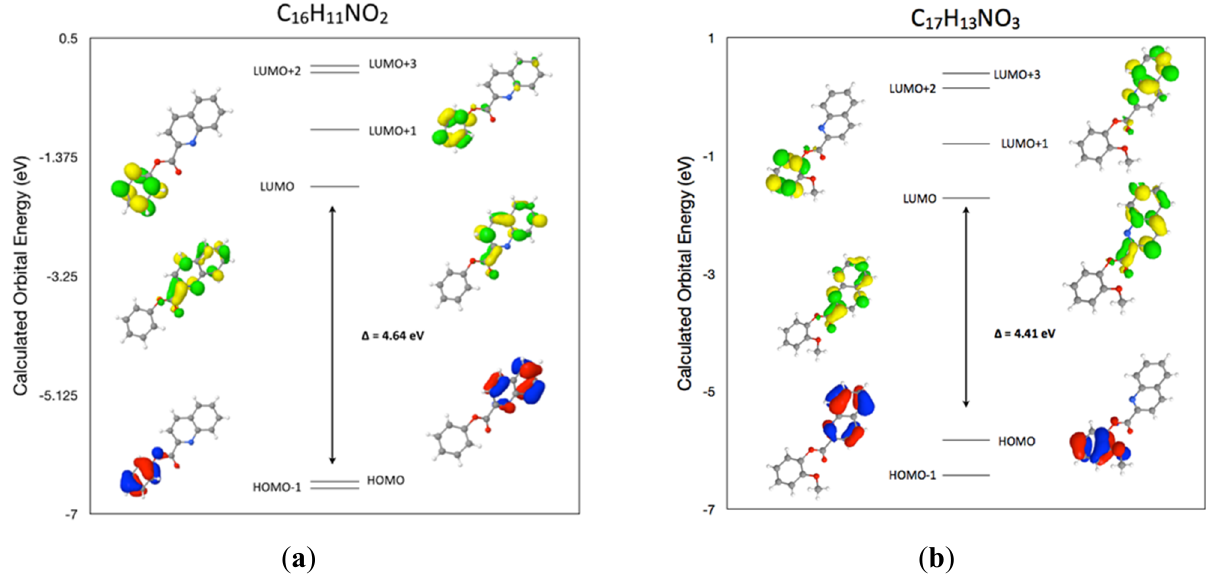
Figure 4. Calculated frontier molecular orbitals for ( I ) and ( II ). ( a ) C 16 H 11 NO 2 ( I ); ( b ) C 17 H 13 NO 3 ( II